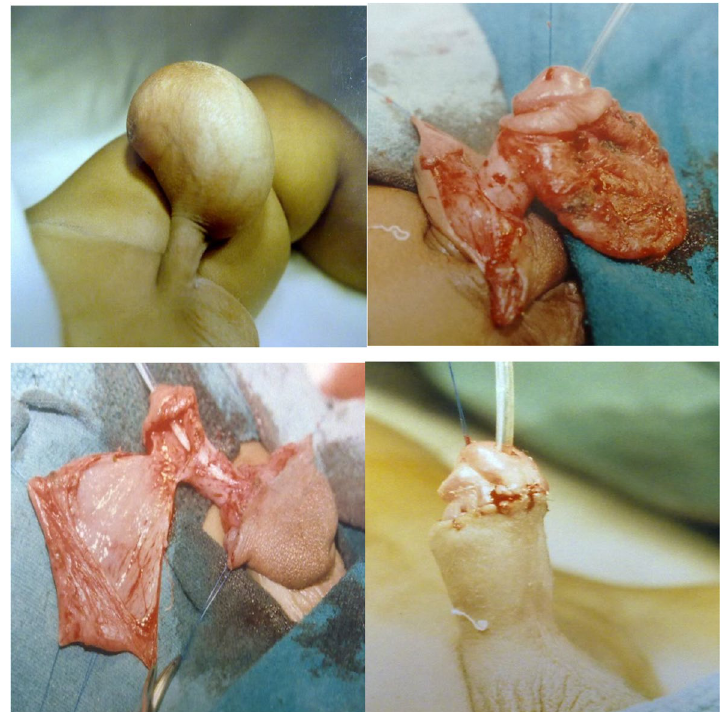
Fig. 5 Case 3. a Preoperative—showing large saccular anterior urethral diverticulum. b Intraoperative—separation of the diverticulum from the surrounding skin. c Intraoperative—excision of the diverticulum. d Postoperative—after